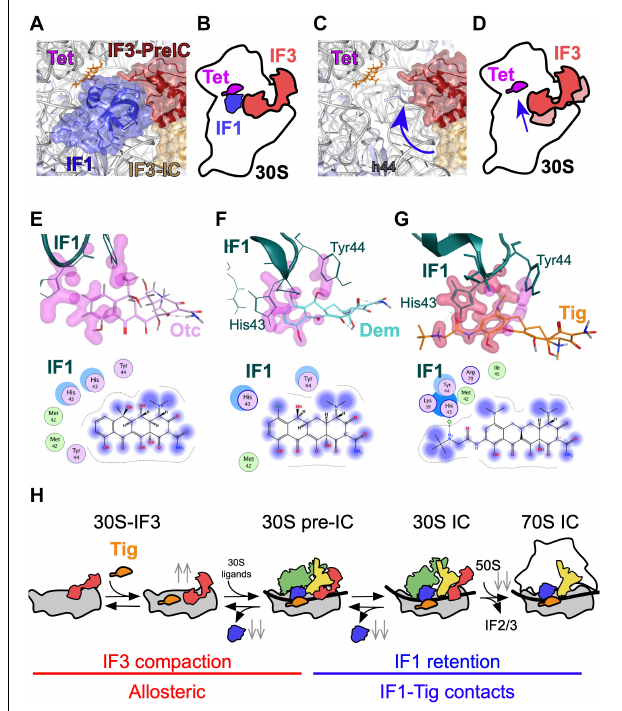
FIGURE 6 | Model of Tetracycline-mediated translation initiation inhibition. (A) Structure of the 30S subunit bound to IF1, tetracyclines, and IF3 in two states, 30S–IFs complex (red, PDB: 5LMV), or in the 30S IC (golden, PDB: 5LMN). (B) Model of IF3 layout on the 30S–IF1–IF3–Tet complex. (C) Structure highlighting IF3 compaction upon binding of Tetracyclines (blue arrow). (D) Schematics representing IF3 compaction as a function of Tetracyclines binding. Structural closeup and interaction maps of the (E) Otc (pink), (F) Dem (aquamarine), and (G) Tig (orange) binding pockets in the 30S IC. Residues of IF1 that are in close proximity with Tetracyclines are indicated. Interaction maps for panels (E–G) : Blue smudges that are drawn behind tetracycline structures denote the extent of solvent exposure. Arene system contacts involving π – π , π –H, and π –cation interaction are shown in green rings. The dotted outline that surrounds the tetracyclines denotes the distance to the interior pocket. (H) Schematics summarizing the mechanism of Tig-mediated translation initiation inhibition through two major effects, IF3 compaction in early complexes (red) and IF1 retention in late complexes (blue). Gray double arrows indicate the increase (up) or decrease (down) of elemental reactions measured